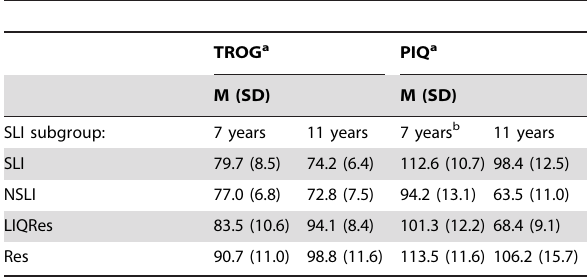
Table 1. Receptive language and PIQ scores for subgrouping children with a history of SLI at 11 years and original scores at 7